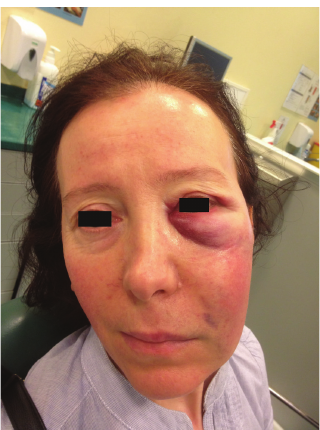
Figure 1: Infraorbital ecchymosis and slight bruising near the naso- labial fold.